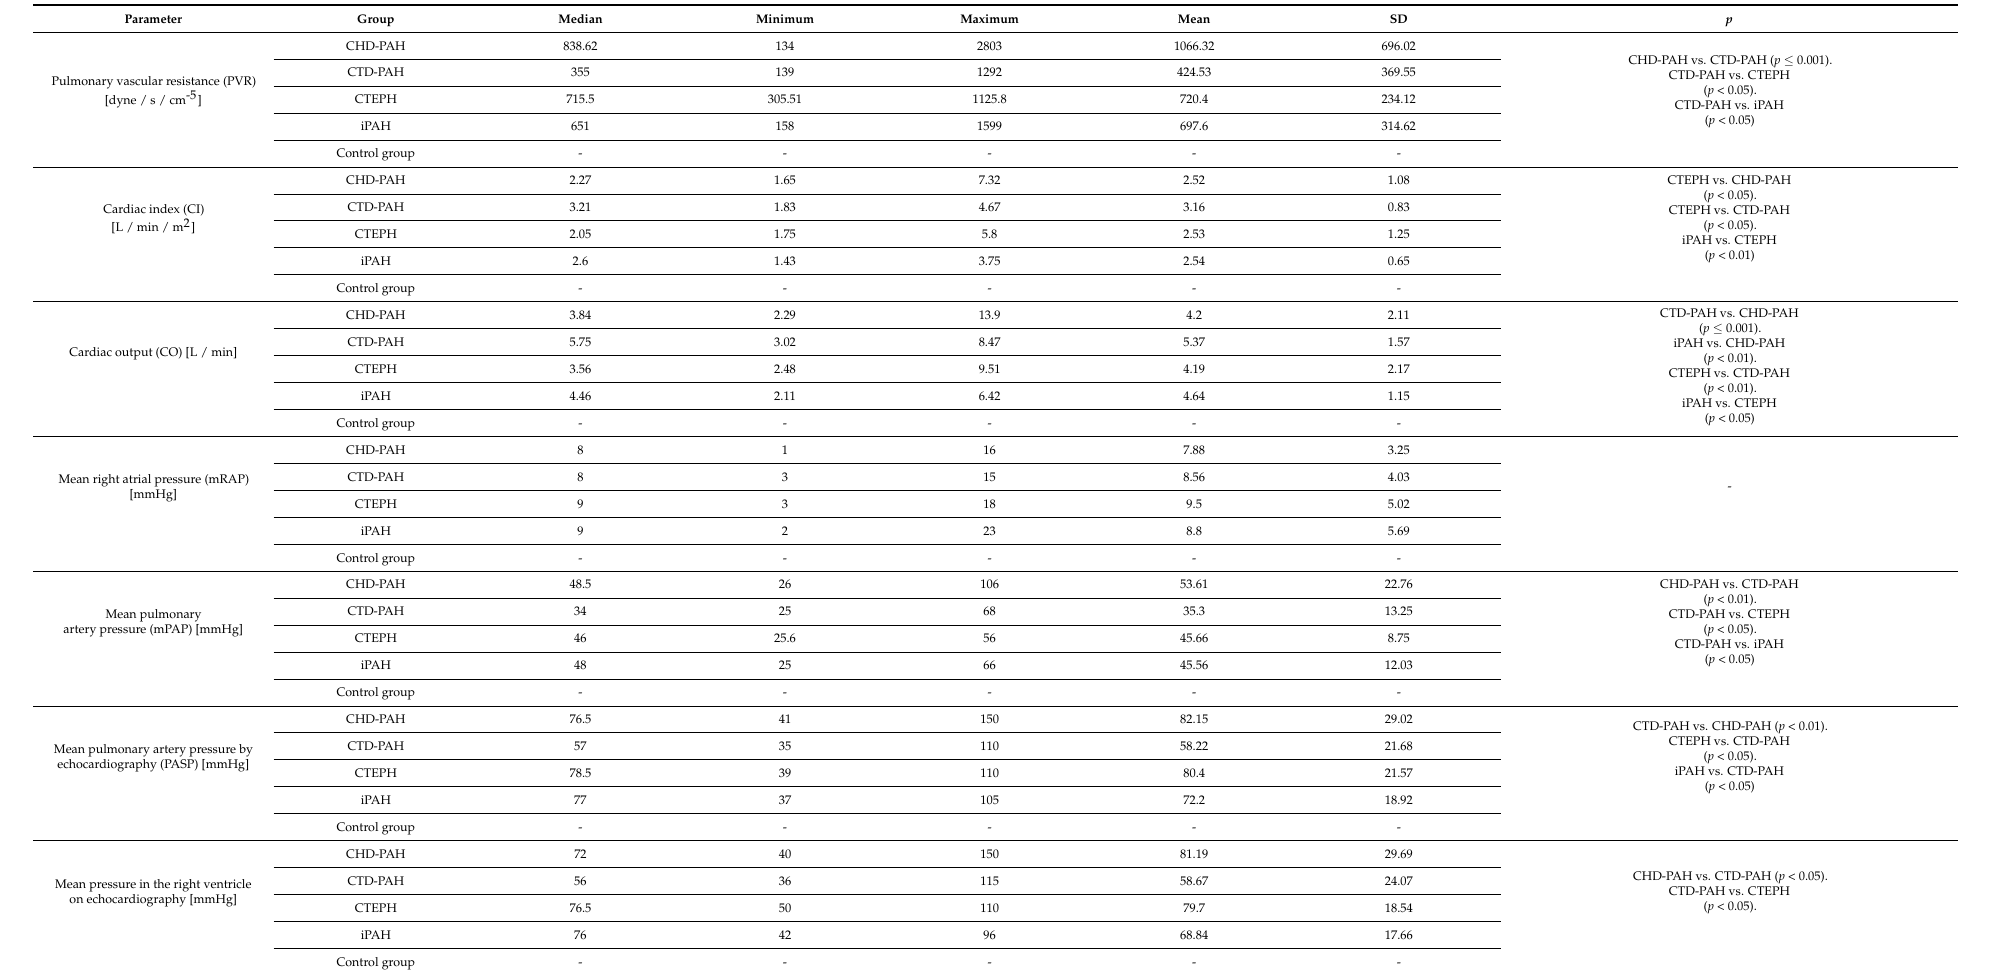
Table 3. Basic hemodynamic parameters assessed during cardiac catheterization and echocardiography in patients with CHD-PAH, CTD-PAH, CTEPH, and iPAH.